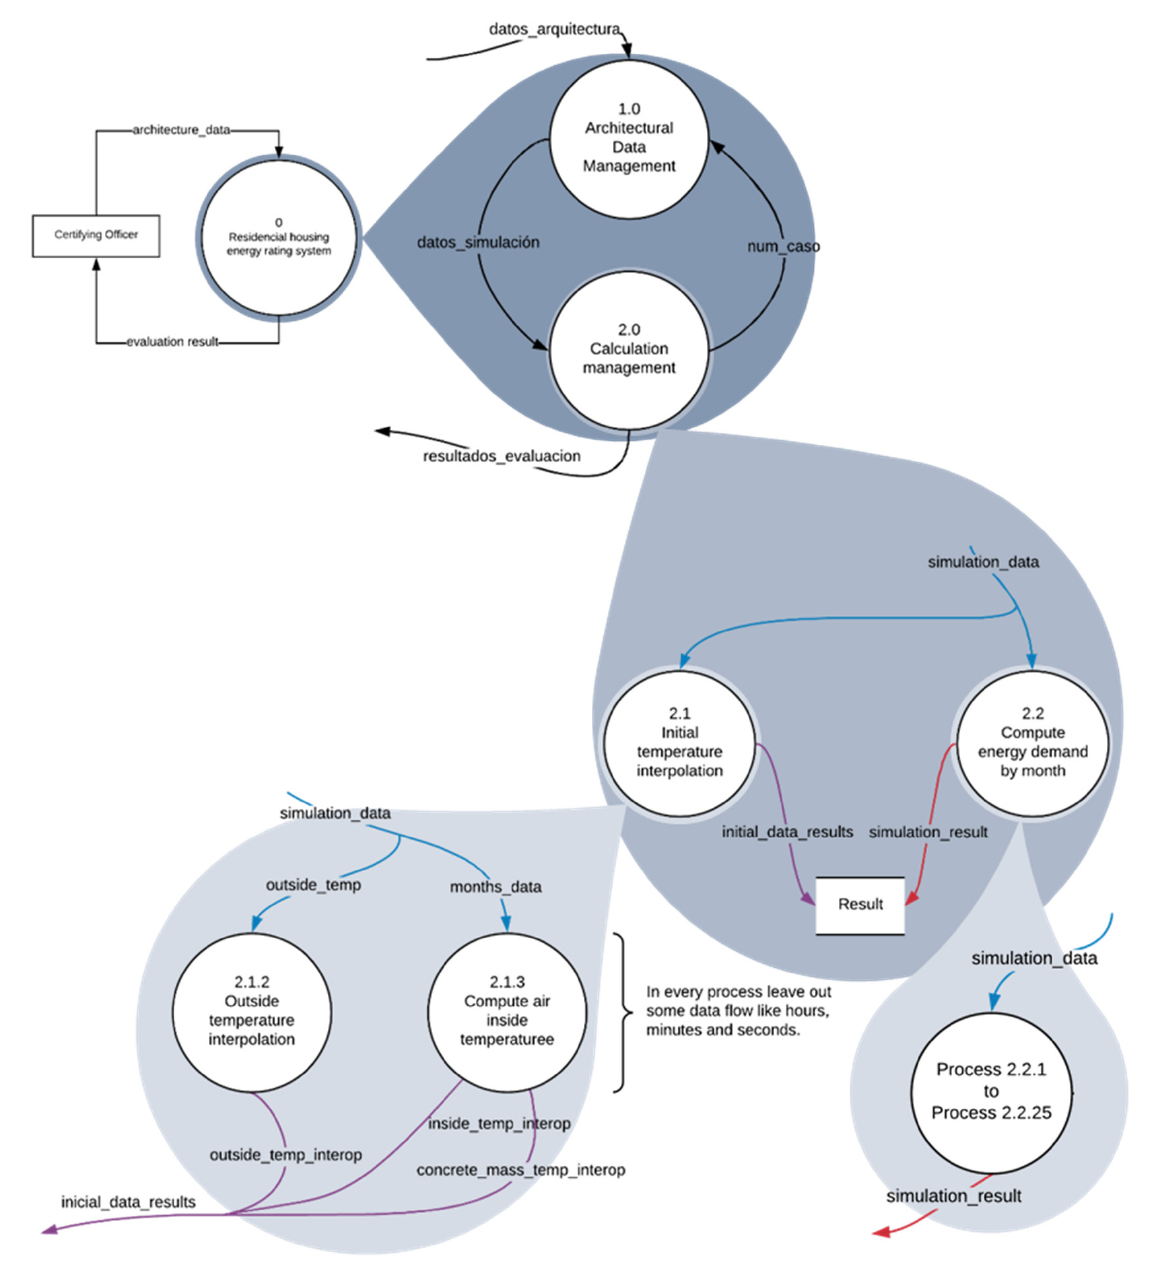
Figure 5. General diagram of the processes for the energy demand calculation (part of the CEV system).